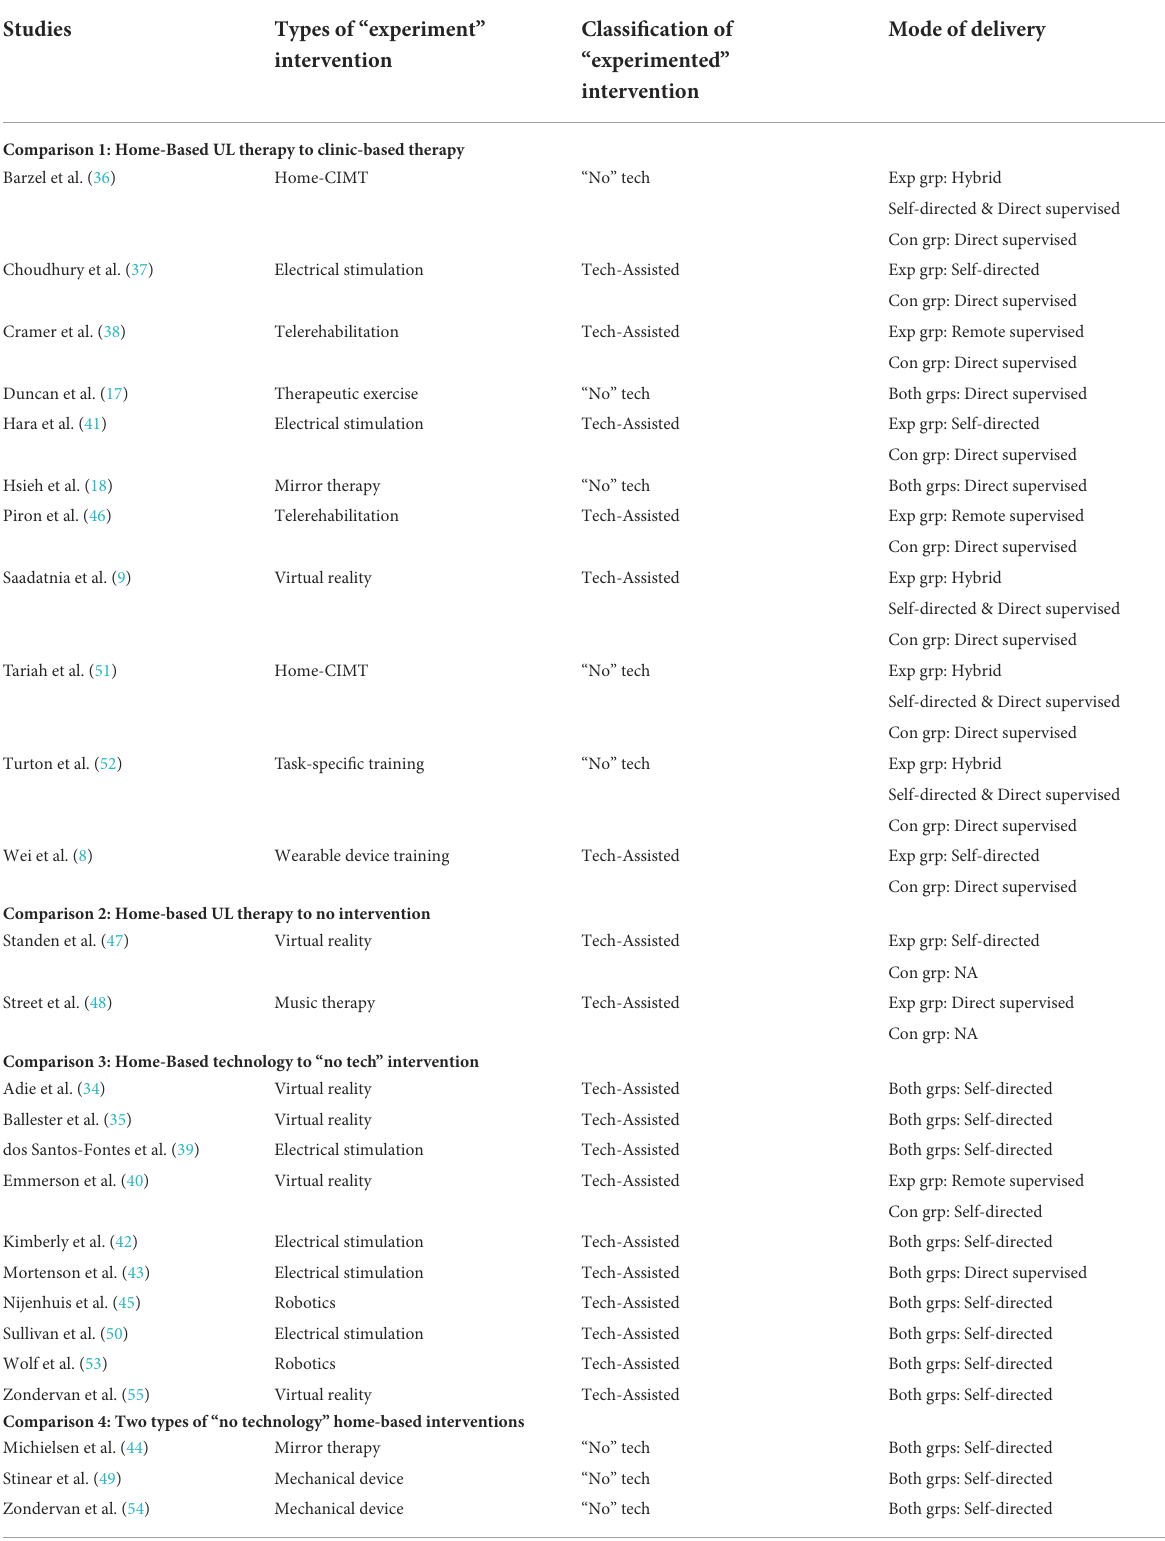
TABLE 3 Types of interventions and mode of